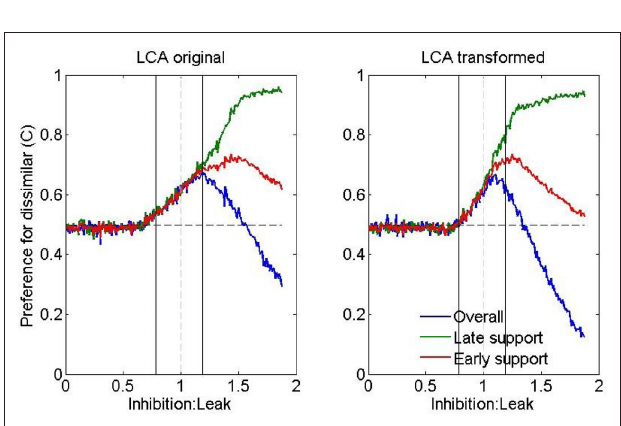
Figure A3 | Figure 6 single trials; with solid lines we show the original single trial activations. With dashed lines we show activations using the transformed input ( Figure A2 right panels).